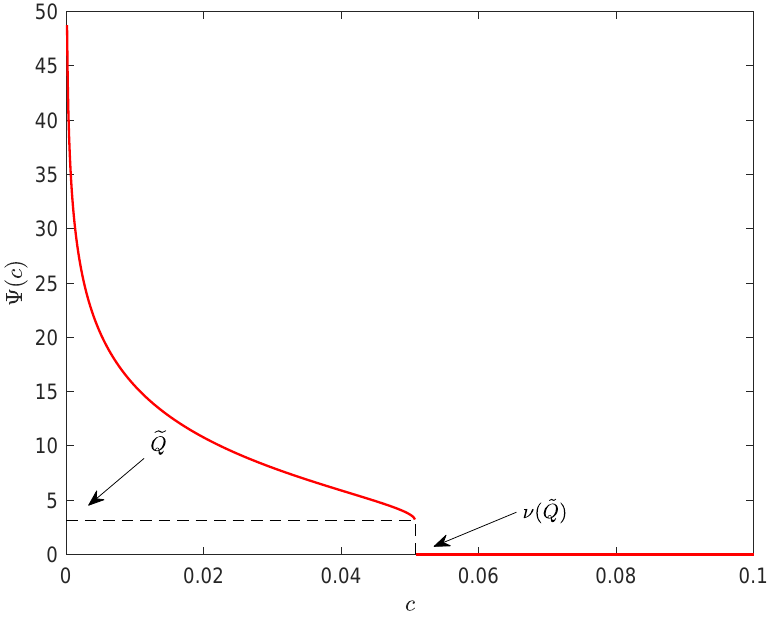
Figure 7. Asymptotic Aggregate Information When Λ (cid:54) =